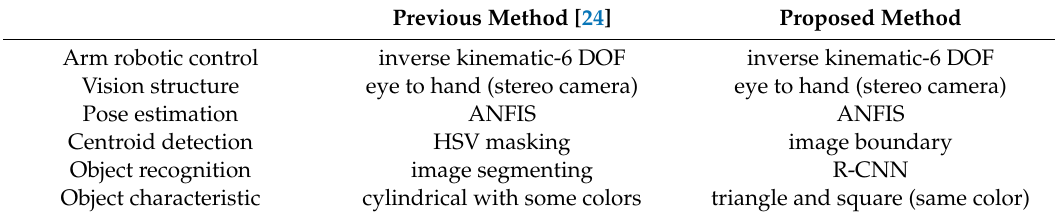
Table 1. Comparison of previous with the proposed method. 6-DOF: six degrees of freedom, ANFIS: adaptive network-based fuzzy inference system, R-CNN: regions with convolutional neural network.